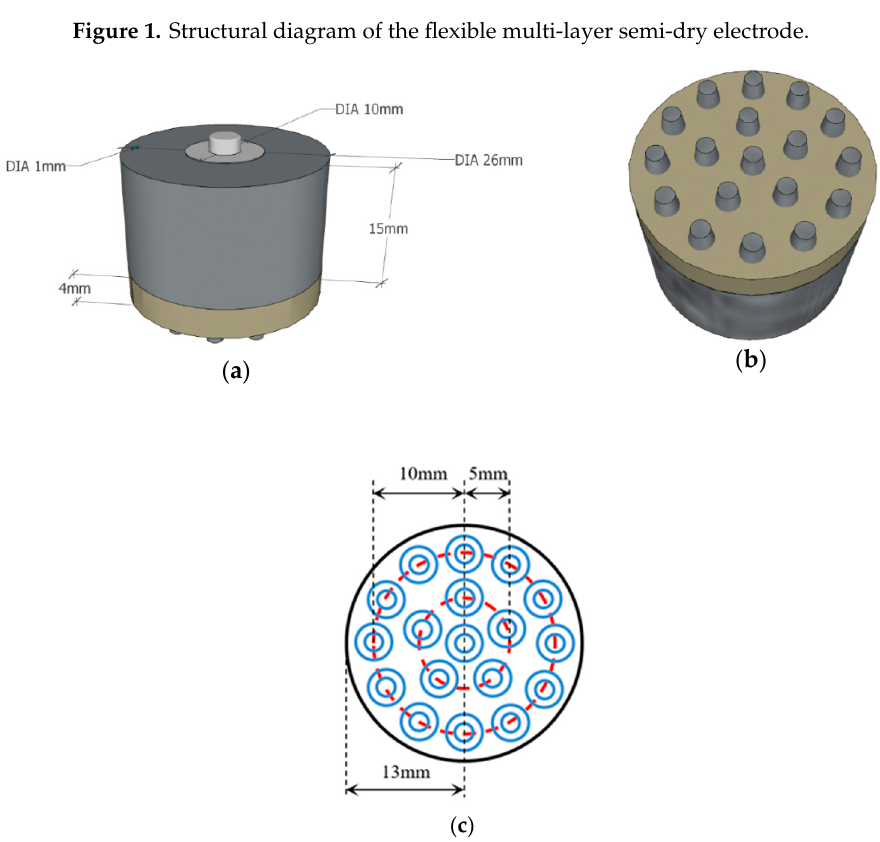
Figure 2. Design diagram of the flexible multi-layer semi-dry electrode: ( a ) front view of the electrode model; ( b ) bottom view of the electrode model; ( c ) schematic diagram of the probe distribution.